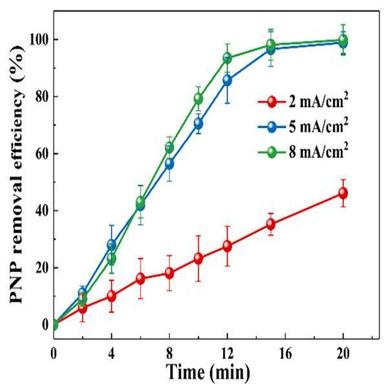
The removal efficiency of PNP by electrocoagulation system at different current densities.